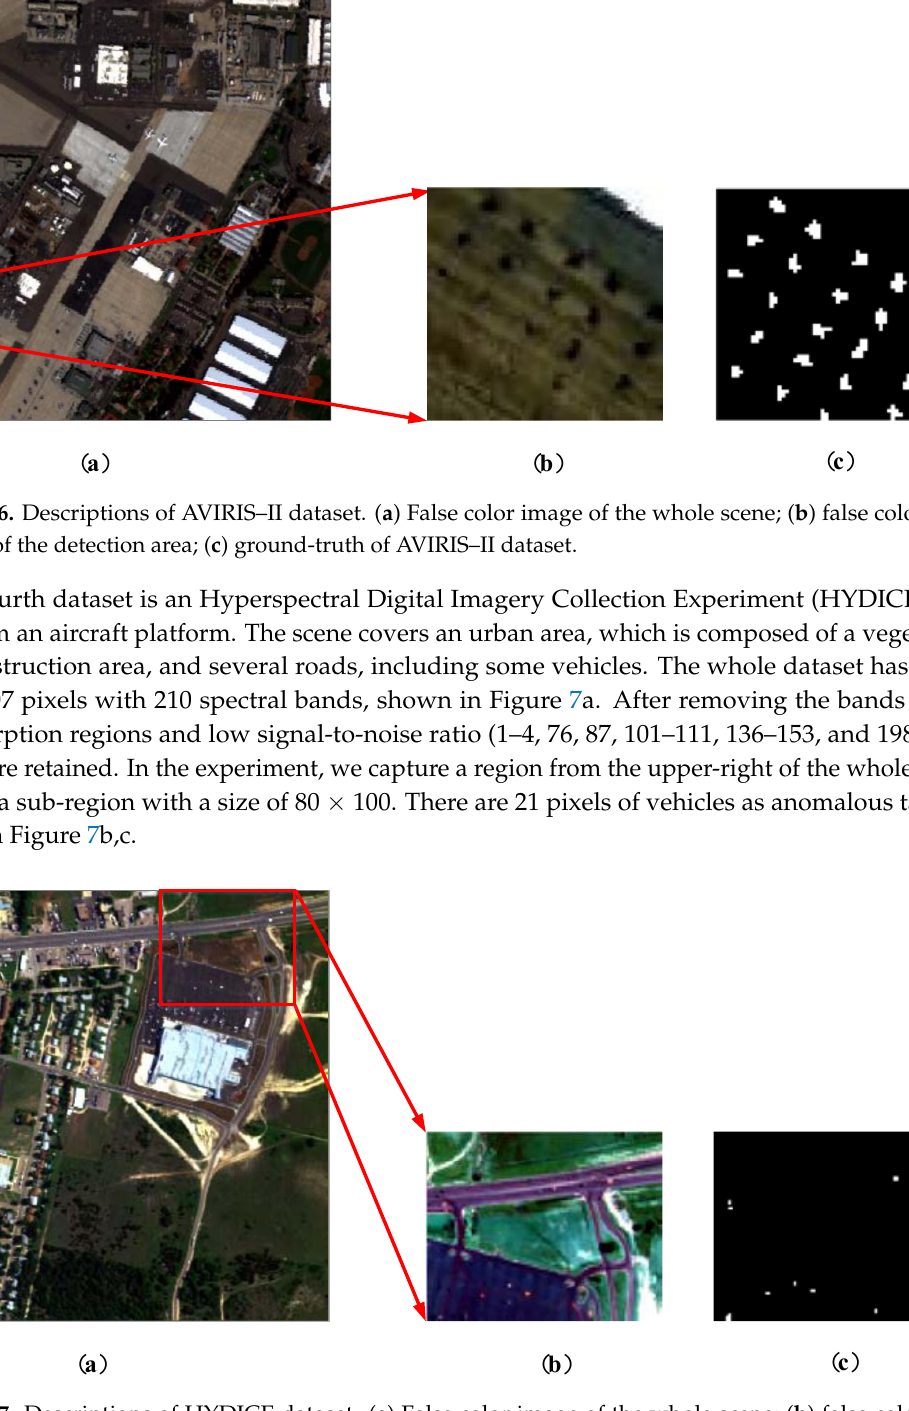
Figure 7. Descriptions of HYDICE dataset. ( a ) False color image of the whole scene; ( b ) false color image of the detection area; ( c ) ground-truth of HYDICE